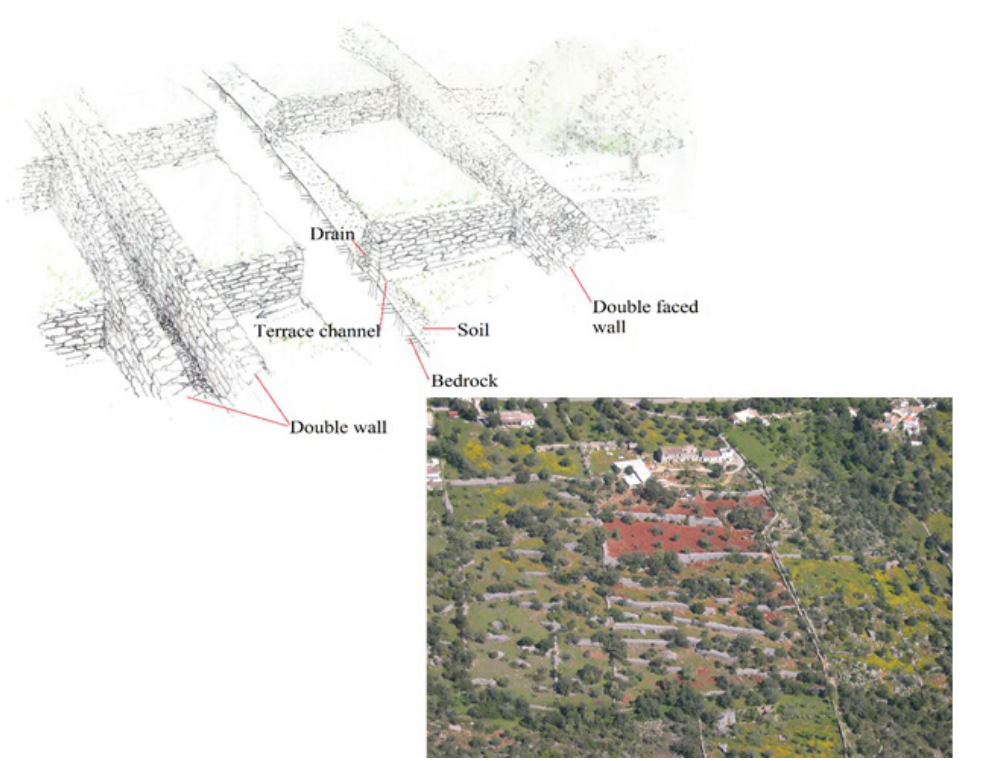
Figure 7: Drainage ditches. Top left: Drainage ditches in a terraced system. Bottom right: Photo near S. Br´as de Alportel where double walling and other perpendicular walls are perfectly